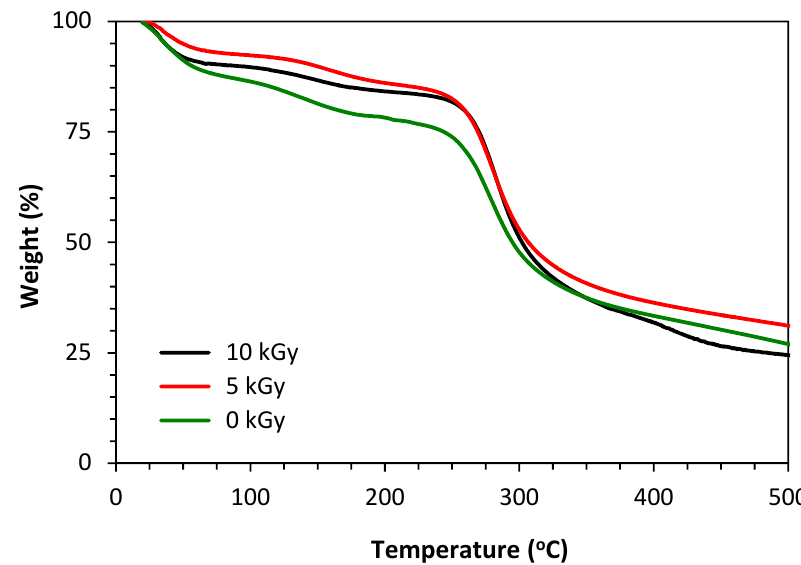
Figure 4. TGA thermograms of non-irradiated and γ -irradiated chitosan/PVP matrices (3% PVP; BF) achieved.